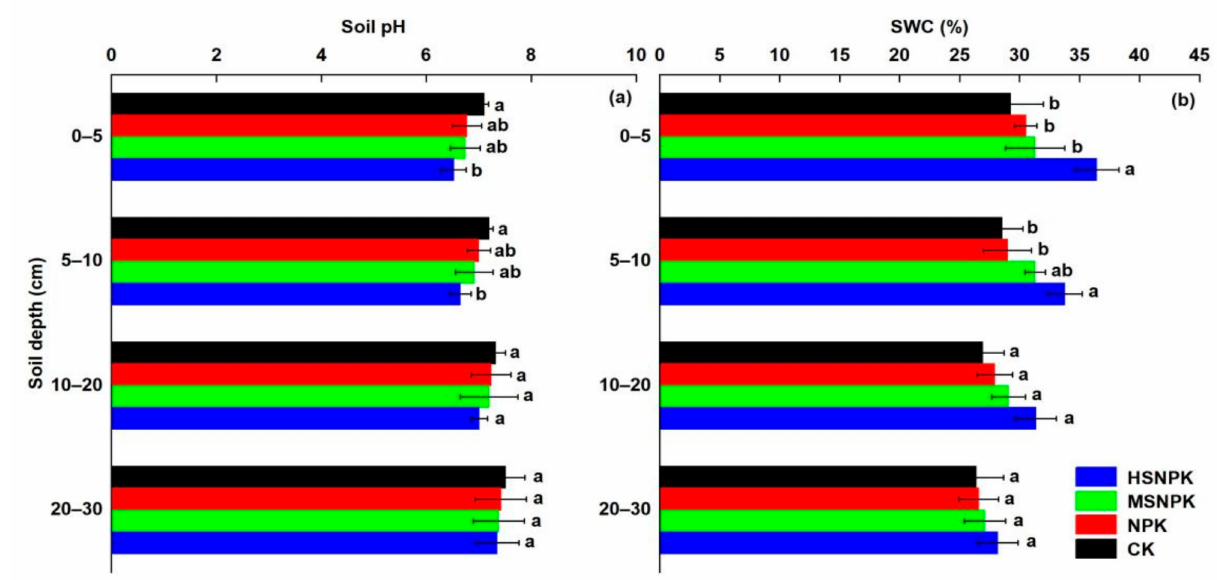
Figure 2. Changes in ( a ) soil pH and ( b ) SWC at different soil layers under different treatments. The values are means ± SD ( n = 3). Different letters mean statistically significant differences at the 0.05 level. CK: unfertilized control; NPK: mineral NPK fertilizer; MSNPK: moderate wheat straw incorporation (3 t ha − 1 ) plus NPK; HSNPK: high wheat straw incorporation (6 t ha − 1 ) plus NPK. SWC: soil water